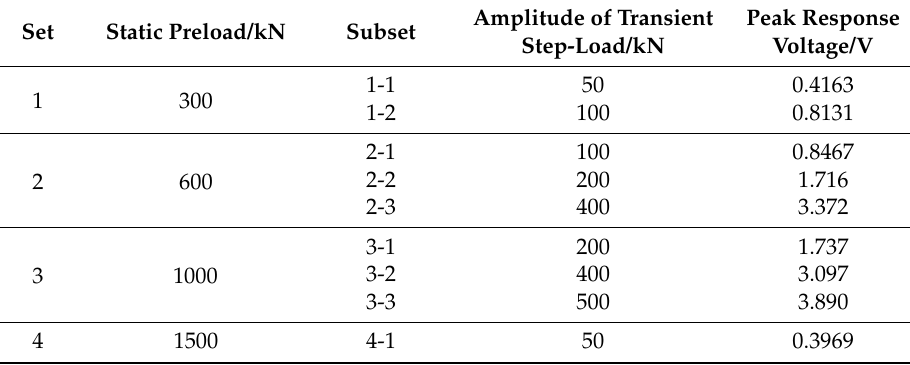
Table 4. Experimental scheme and peak response voltage of every subset.